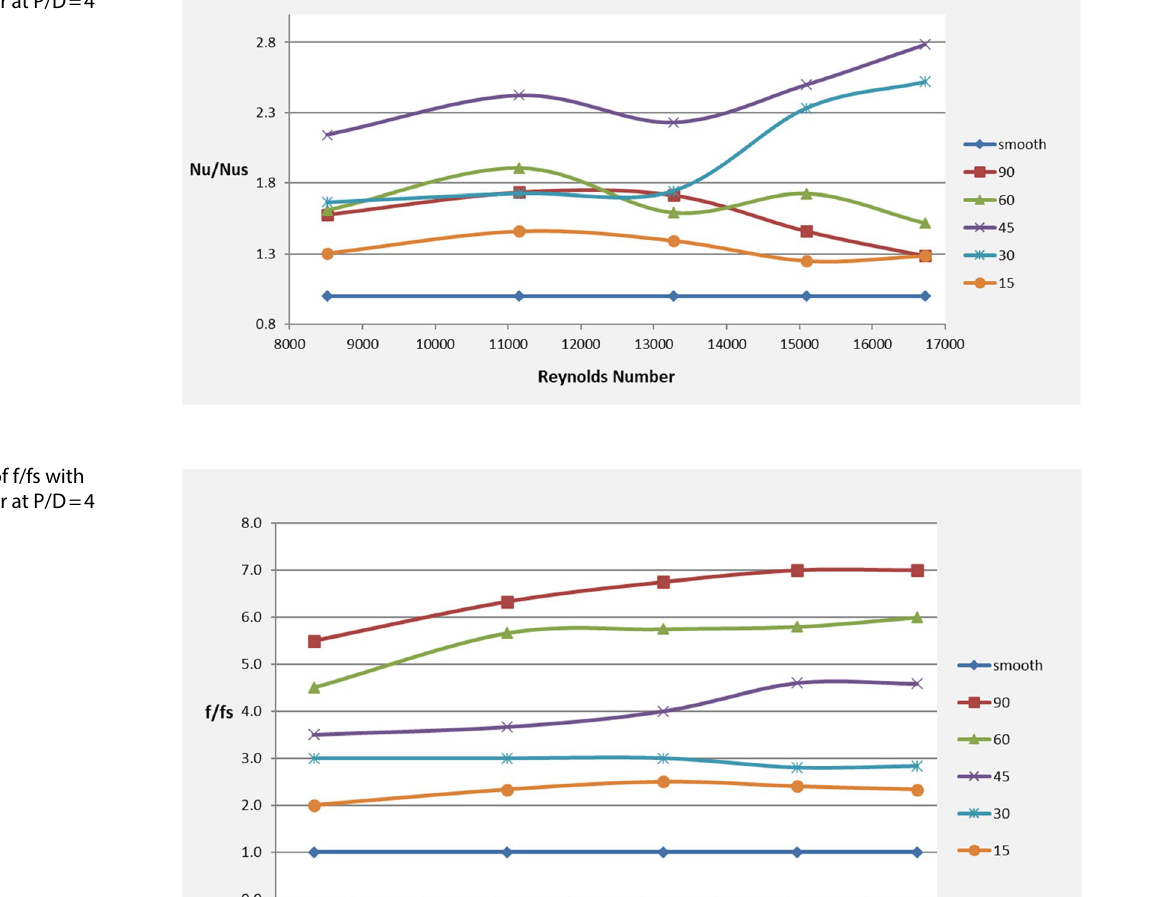
Fig. 7 Variation of Nu/Nus with Reynolds Number at P/D = 4